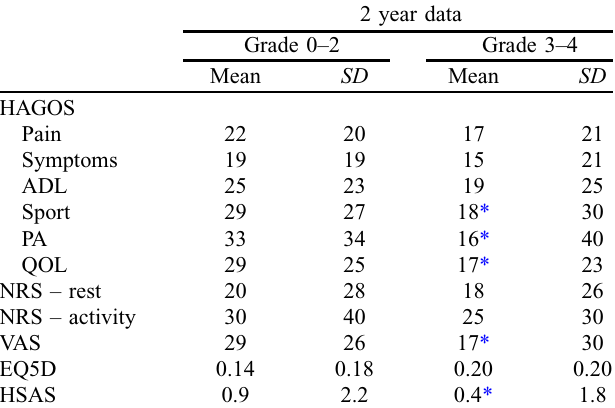
Table 4. Outcome differences between 2 years FU and baseline values.